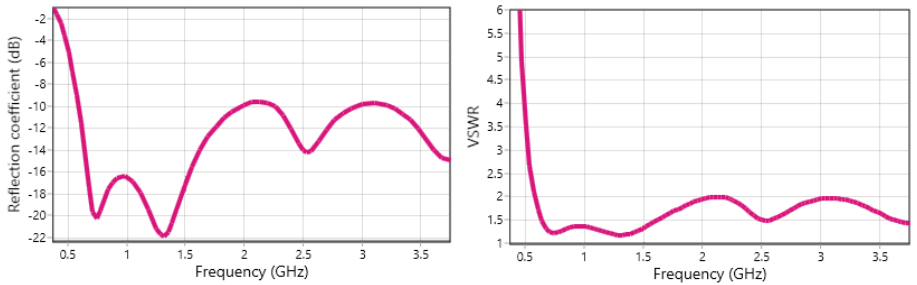
Figure 2. Reflection Factor in dB (left) and standing wave ratio (SWR) versus frequency (right) of the discone antenna’s simulation results.